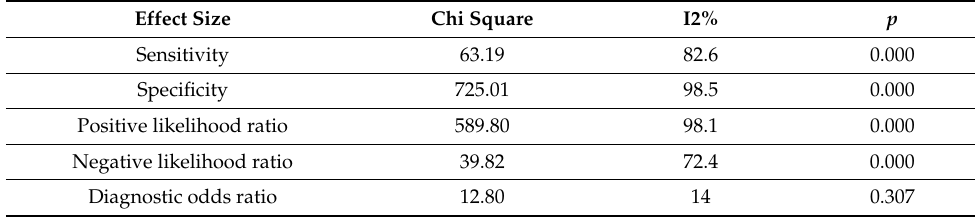
Table 4. Statistical heterogeneity evaluation